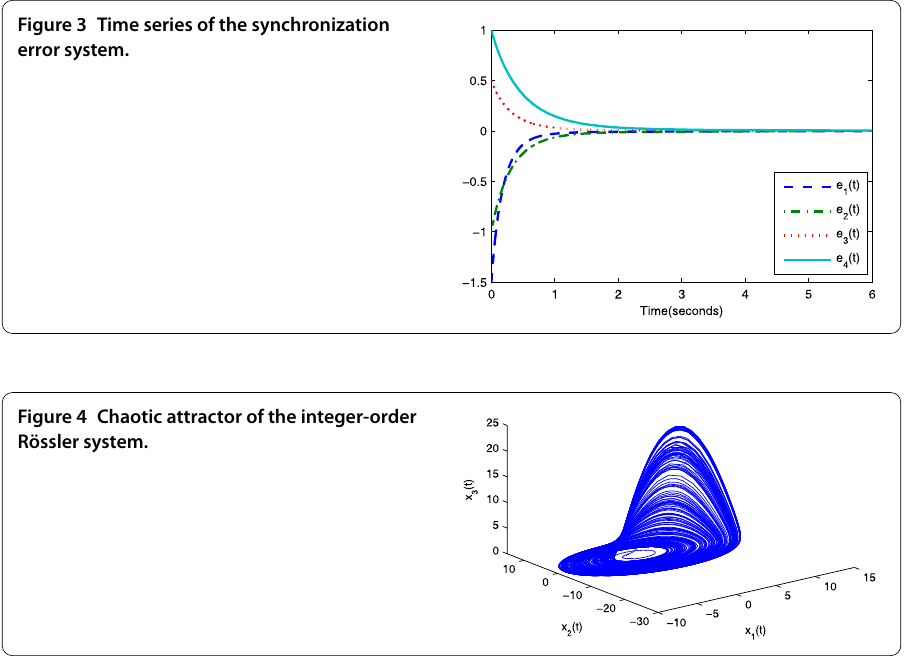
Figure 3 Time series of the synchronization error system.